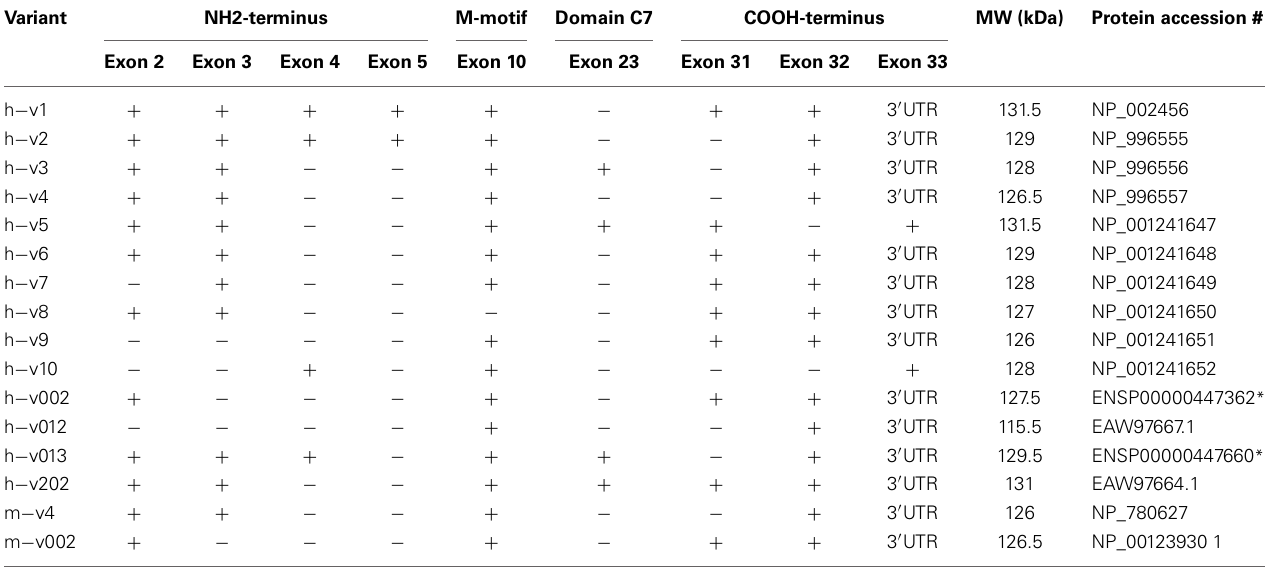
Table 1 | Human and mouse variants of